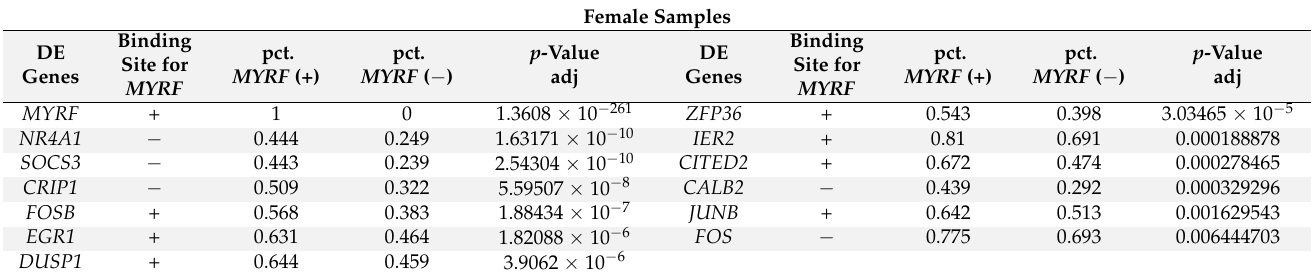
Figure 3. Expression levels of MYRF in testes ( A ) and ovaries ( B ) at embryonic and fetal stages, showing that it is highly expressed in coelomic epithelium cells. Table 1. List of genes differentially expressed between the cells that express MYRF and those that do not, in the coelomic epithelium cluster of ovaries.